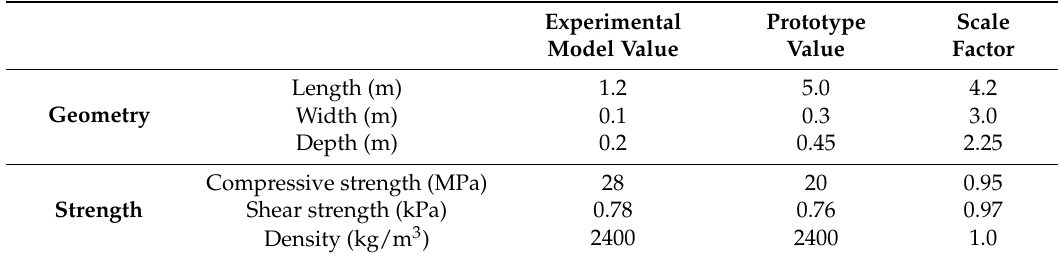
Table 5. Geometric and mechanical properties of the prototype and models for Beams.